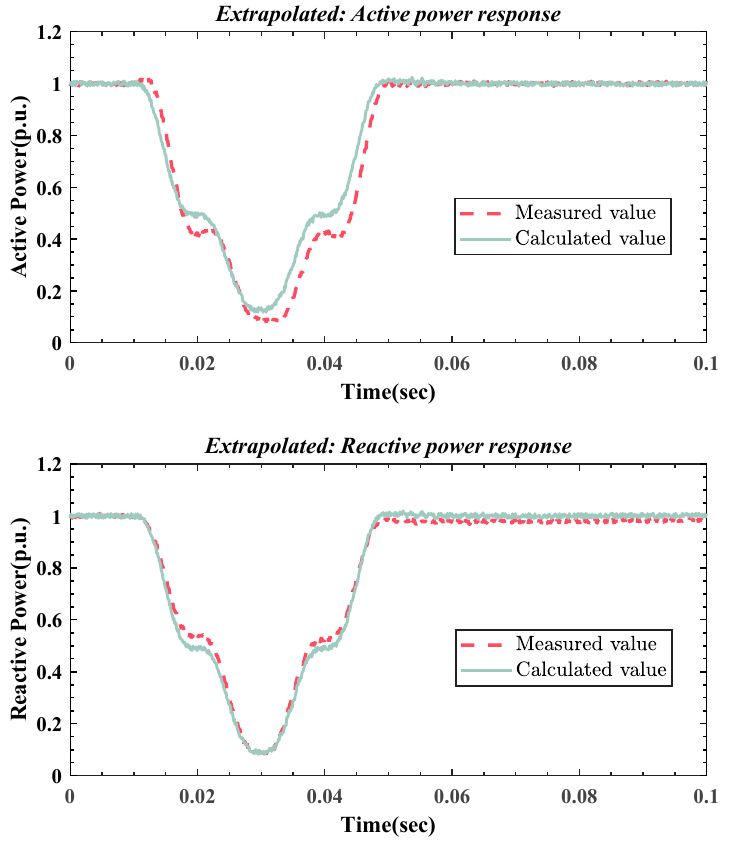
Figure 11. Extrapolation fitting curve of measured data and calculated data.